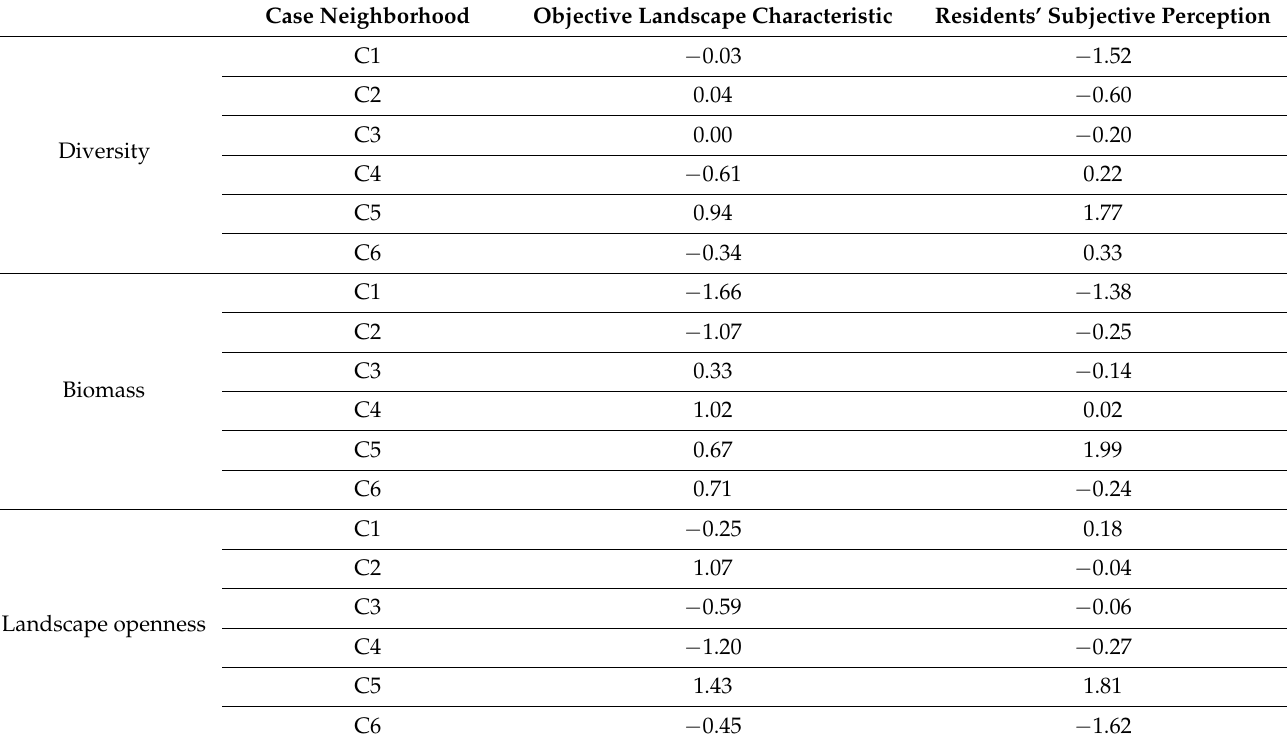
Figure 7. Building density and building space crowdedness of the six case neighborhoods. Table 4. Structure of green quantity of